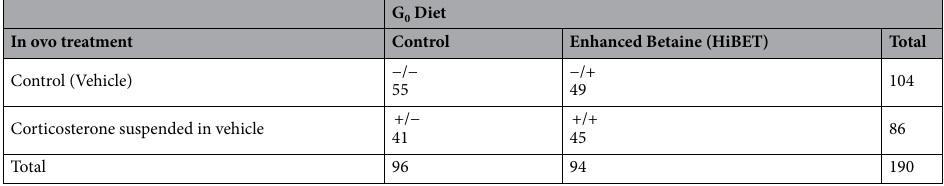
Table 1. Experimental 2 × 2 factorial design representing the number of G 1 individuals in each category with complete data sets; Diet/treatment key: − = no diet or treatment applied, + = diet or treatment